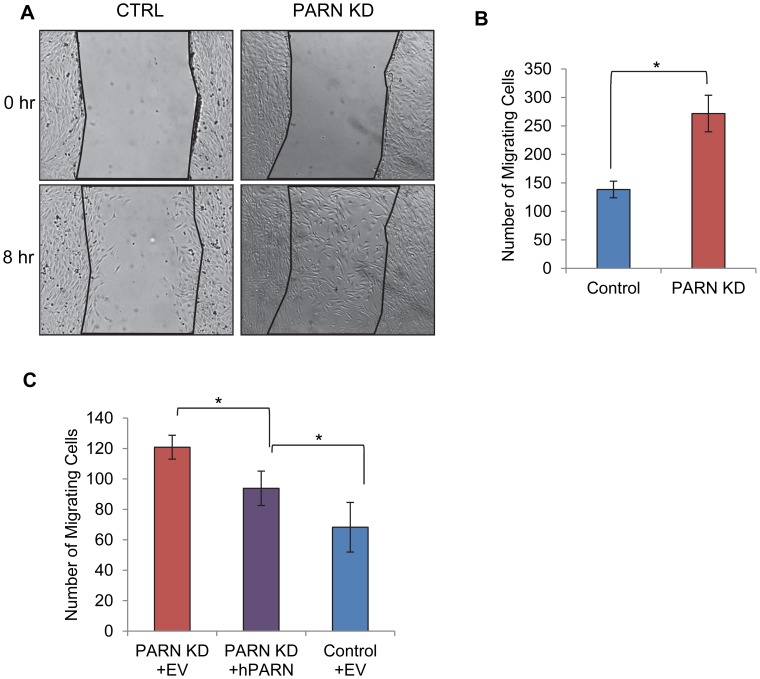
PARN knockdown results in enhanced wound healing.(A) CTRL and PARN KD were grown to confluency and displaced from the plate by scratching with a pipette tip. Wounds were allowed to heal over a period of eight hours and then the number of cells that had migrated into the wound was counted. (A) Brightfield images of the wounds in each cell line before and after incubation. (B) Graph showing the quantification of triplicate wound healing assays similar to those shown in (A). The error bars represent the standard deviation. (C) Graph showing the number of cells migrating into the wound in CTRL and PARN KD cells transfected with empty vector, and PARN KD cells transfected with a vector encoding human PARN. Error bars represent the standard deviation. All differences were statistically significant (*p<0.05).